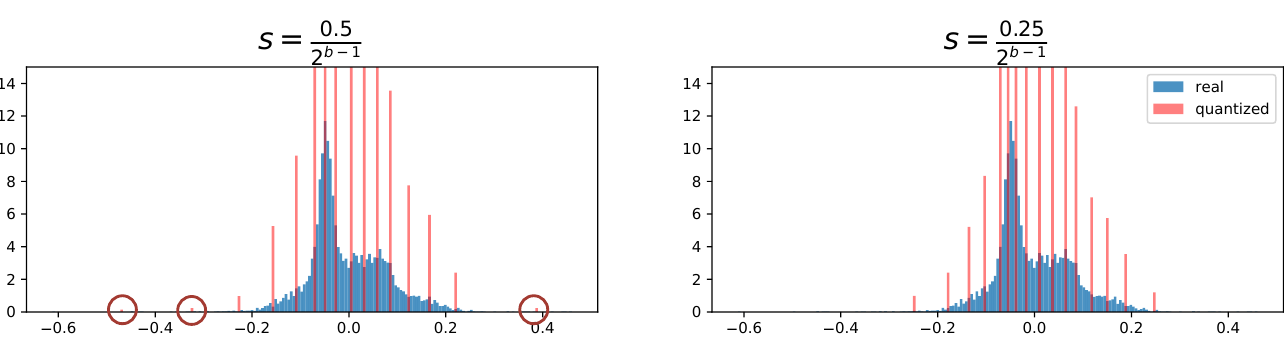
Figure 7. Real and quantized (16 bins) distributions of a weight tensor from MobileNetV2, generated using Algorithm 1. On the left, a few quantization bins are assigned to outliers due to the larger scale factor s . On the right, a smaller s results in a more compact quantized distribution because of the clamp